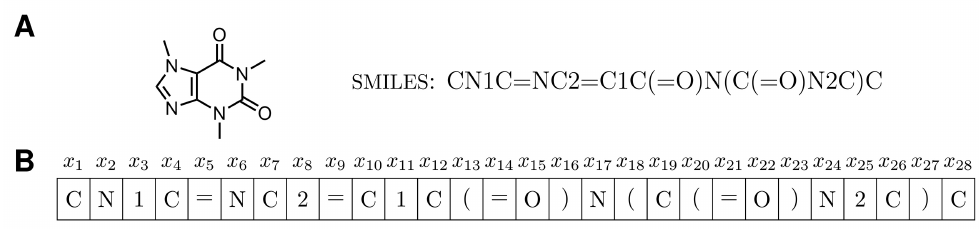
Figure 3. ( A ) Structural formula and SMILES string of caffeine. ( B ) Caffeine SMILES string split into a sequence of tokens x = ( x 1 , . . . , x t )